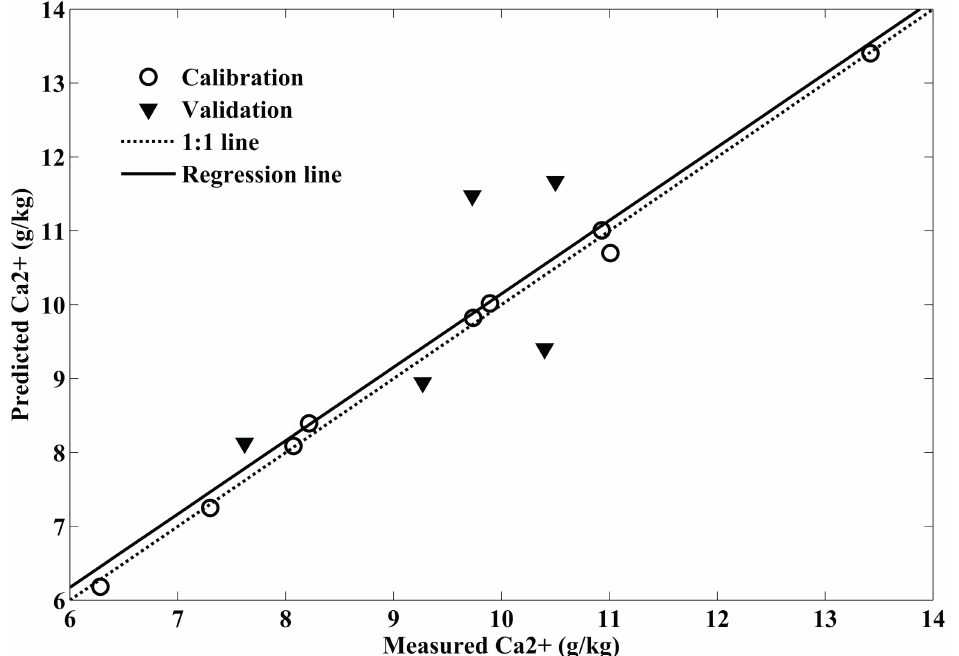
Figure 4. Estimation of Ca 2+ abundance through application of PLS to Hyperion image